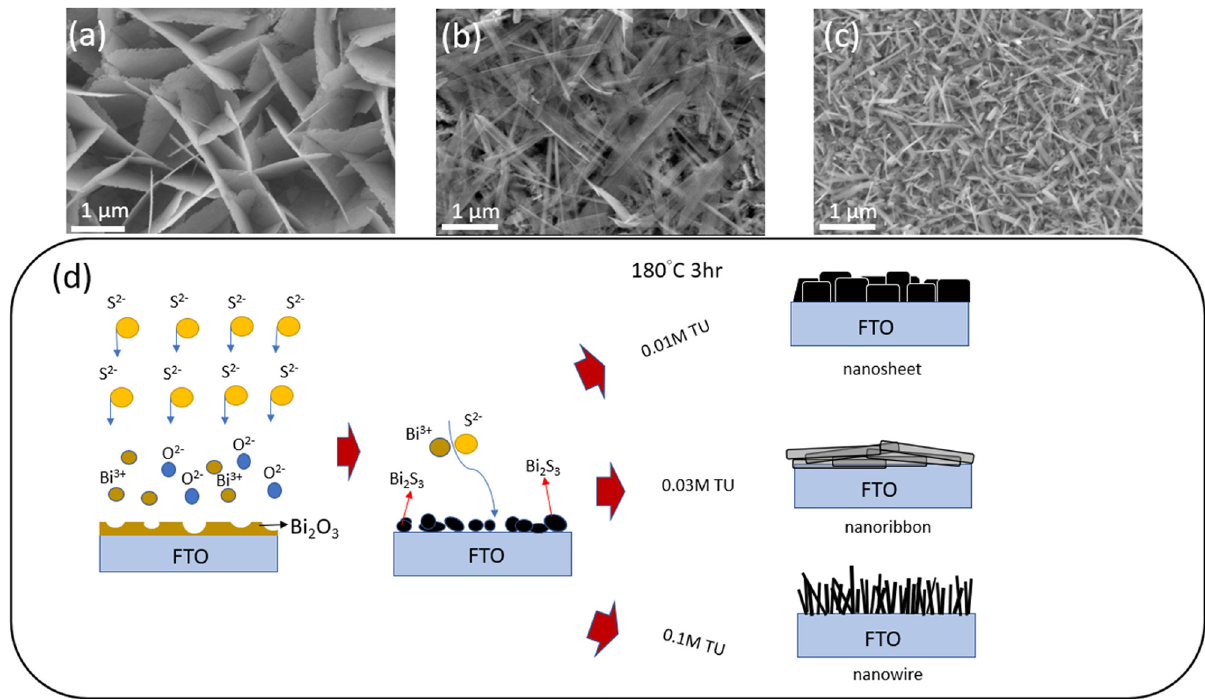
Figure 1: SEM micrographs of Bi 2 S 3 crystals formed with Bi 2 O 3 thin - fi lm templates from various vulcanization processes: ( a ) 0.01 M TU, ( b ) 0.03 M TU, and ( c ) 0.1 M TU. ( d ) Illustration of formation mechanisms of Bi vulcanization processes. The Bi 2 S 3 crystallographic plane has been marked in